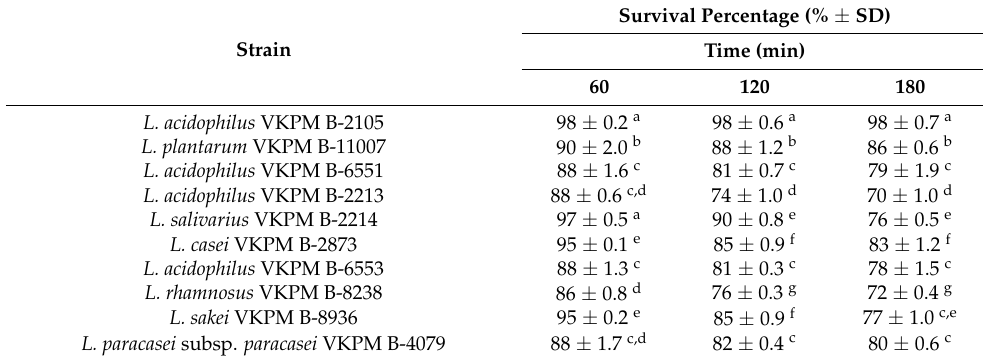
Table 9. Tolerance of Lactobacillus strains to